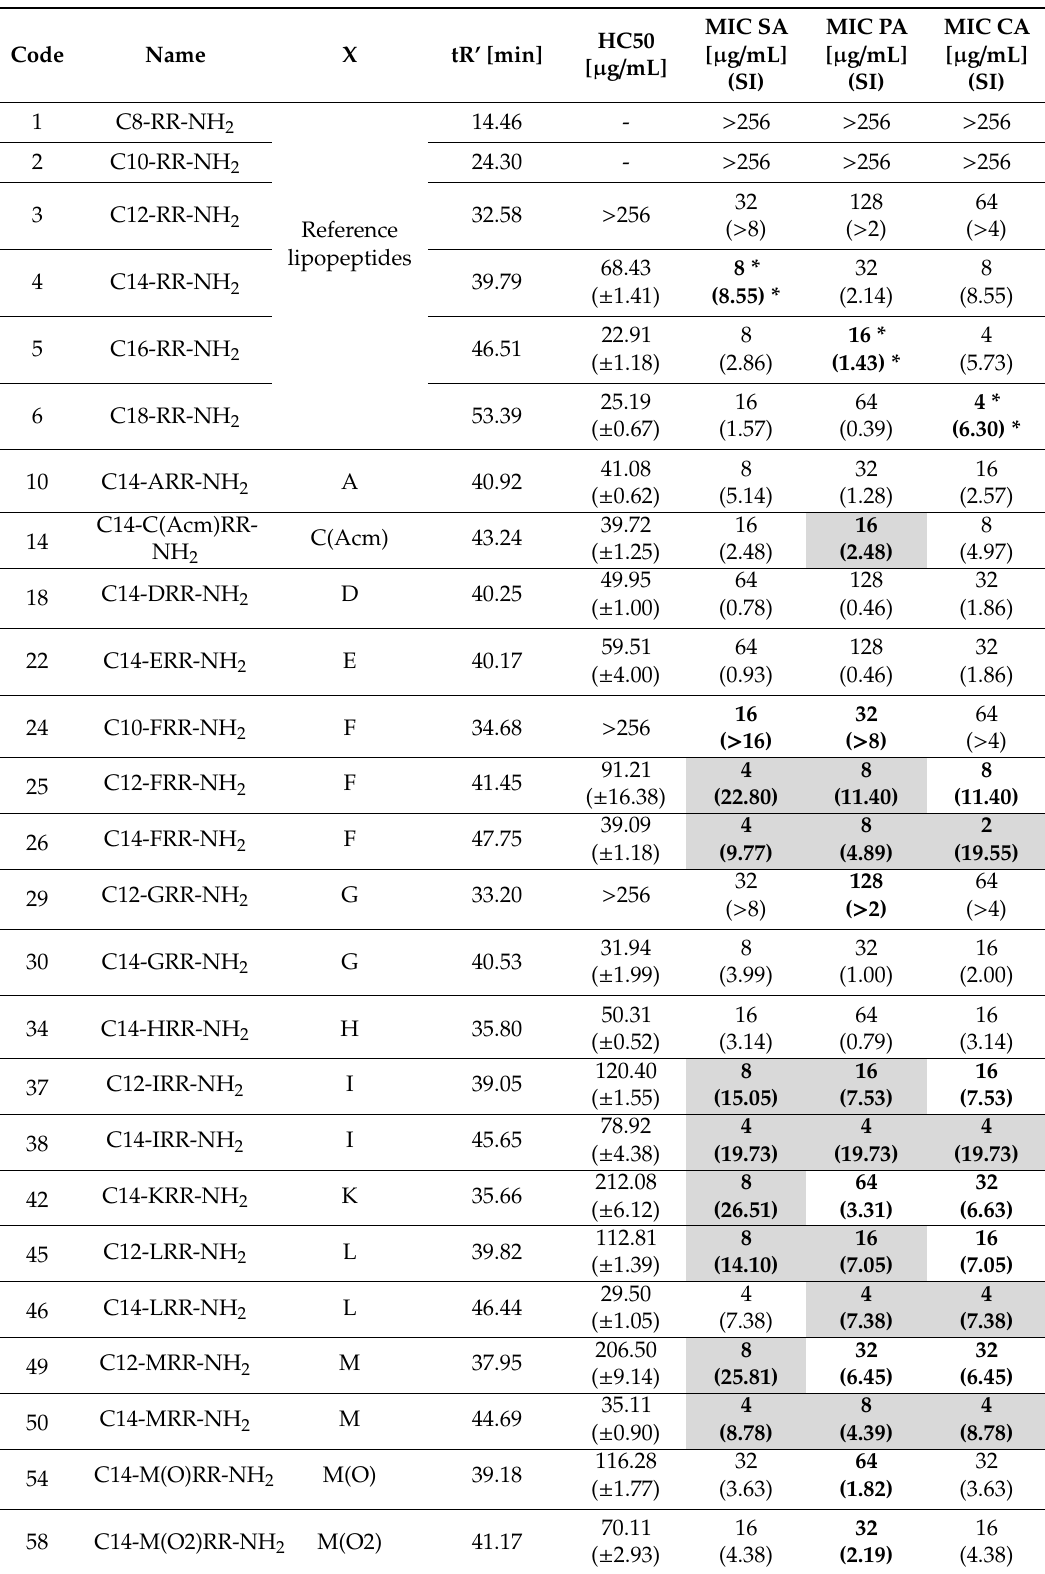
Table3. Antimicrobialandhemolyticactivities, selectivityindexesandretentiontimeofthelipopeptides.